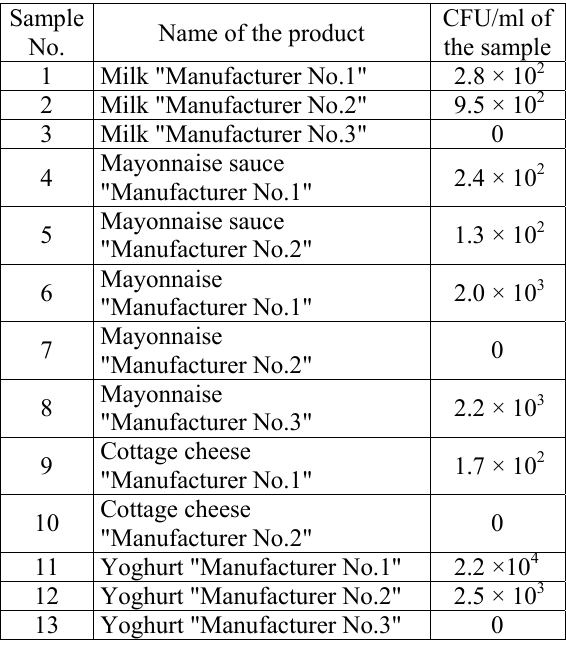
Table 3. Number of microorganisms from the